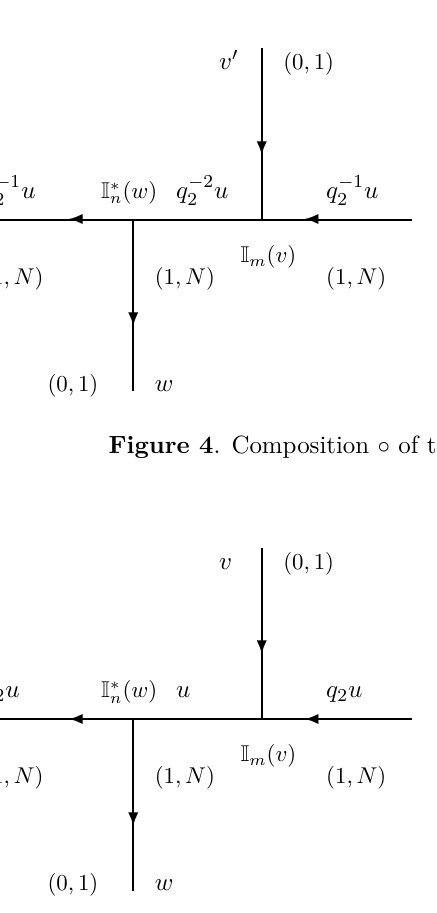
Figure 5 . Composition ◦ of the dual vector intertwiner and the shift